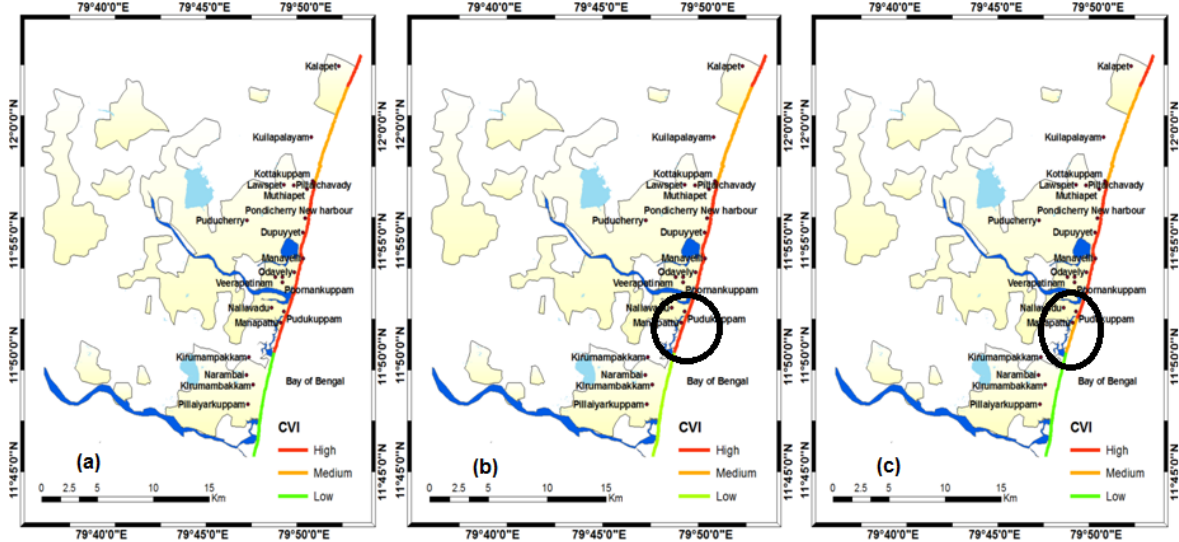
Fig. 14. Sensitivity analysis: Comparison of CVI maps with different weights – (a) Coastal Vulnerability Index Map (Saaty’s Number for Geomorphology: 8, Regional Elevation: 7, Significant wave height: 2 and Tidal range: 1, (b) Coastal Vulnerability Index Map (Saaty’s Number for Regional Elevation: 8, Geomorphology: 7, (c) Coastal Vulnerability Index Map (Saaty’s Number for Tidal Range: 2, Significant wave height: